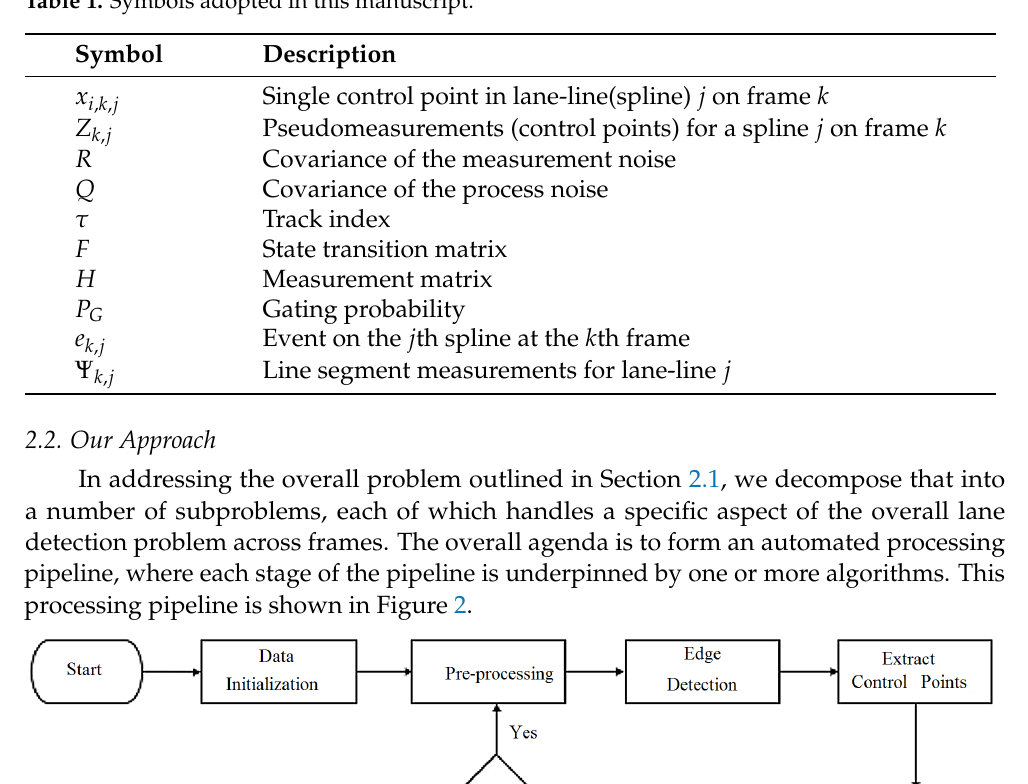
Table 1. Symbols adopted in this manuscript.